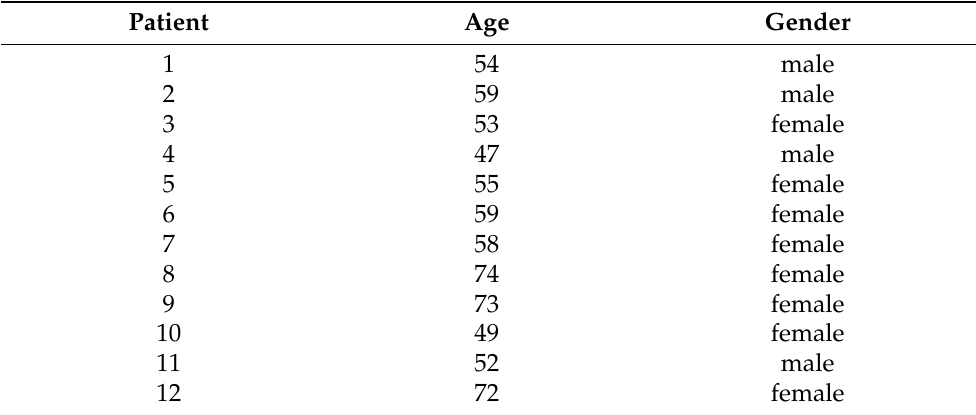
Table 1. Patients enrolled by age and